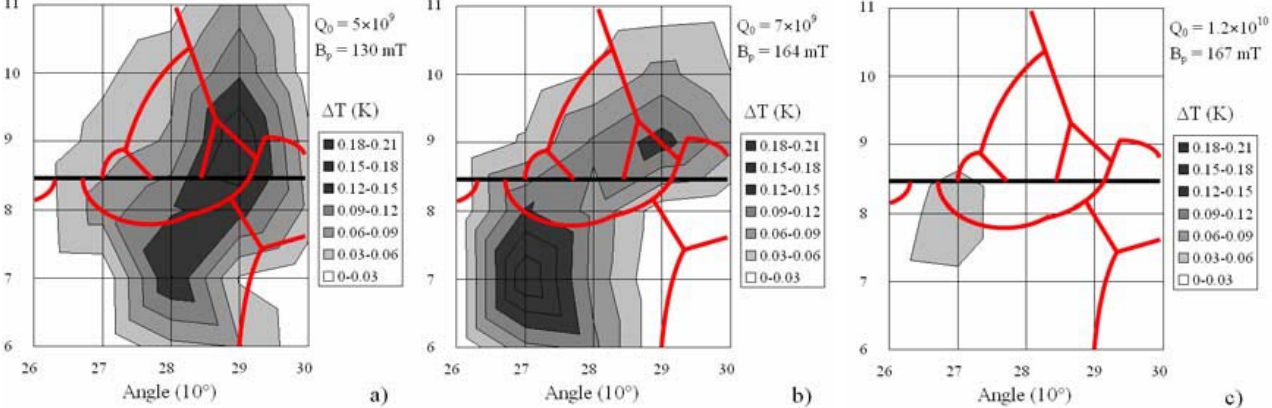
FIG. 22. (Color) Temperature map for few thermometers surrounding a hot spot measured in the test after postpurification (a), after 120 (cid:3) C , 3 h in situ bake (b), and after additional 120 (cid:3) C , 6 h in situ bake (c). The thick red lines represent grain boundaries and the thick black line represents the equator